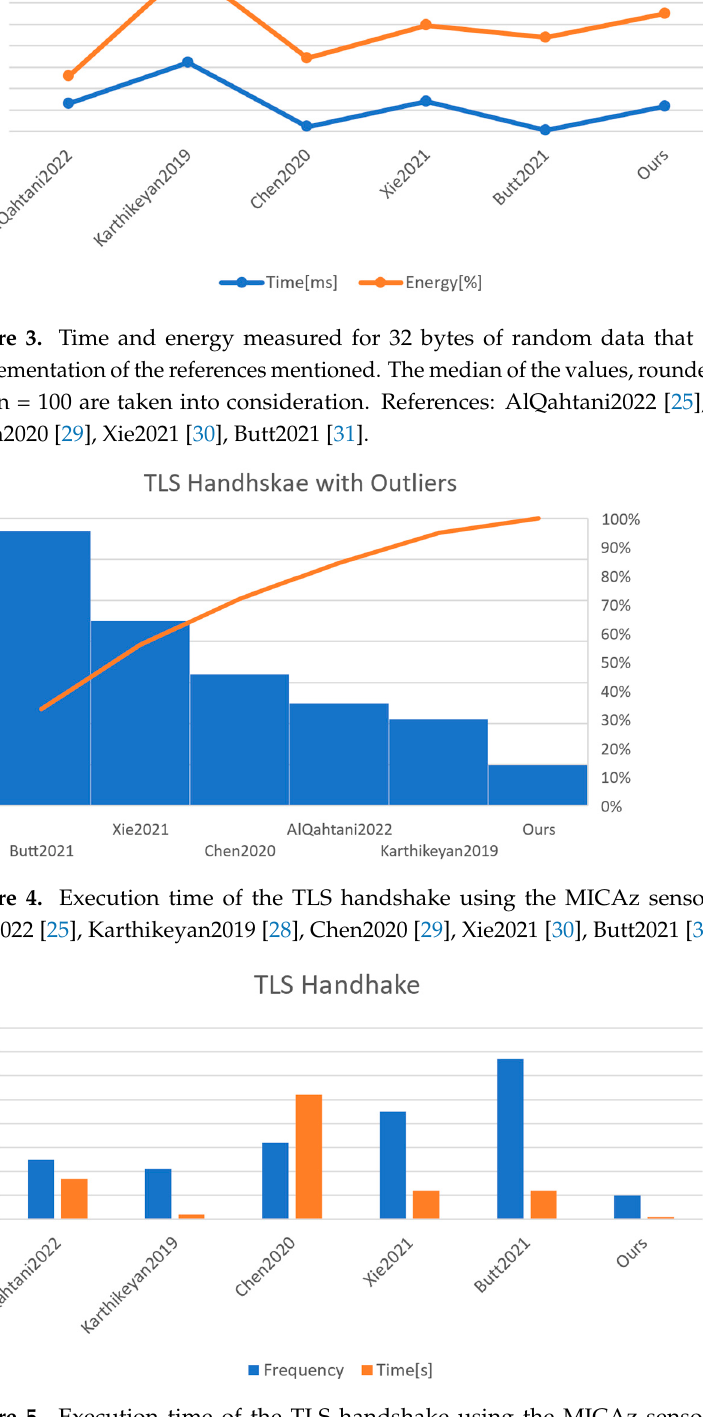
Figure 5. Execution time of the TLS handshake using the MICAz sensor without outliers and which has more than 25% from the median. References: AlQahtani2022 [25], Karthikeyan2019 [28], Chen2020 [29], Xie2021 [30], Butt2021 [31].